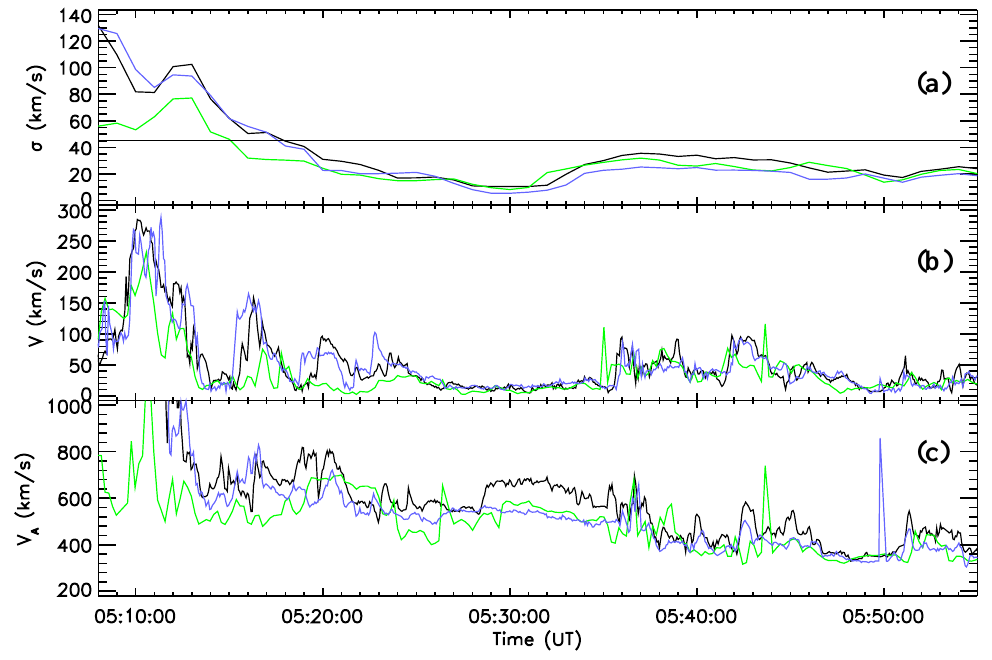
Fig. 4. Variance ( σ ) of the plasma velocity shown (a) during each ∼ 6.1-min interval used in the power spectral slope calculations. The total plasma velocity (b) and the Alfv´en speed (c) measured by sc1, sc3 and sc4 between 05:00–06:00 UT are shown.